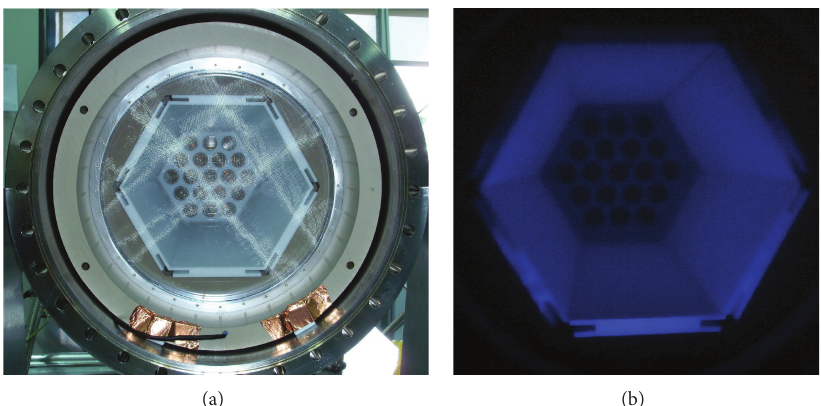
Figure 24: View of the light tube from the position of the tracking plane. (a) The meshes of the EL region can be seen in the foreground, and in the background, at the end of the light tube, the PMTs of the energy plane are visible. (b) The light tube of NEXT-DEMO illuminated with a UV lamp after being coated with TPB.